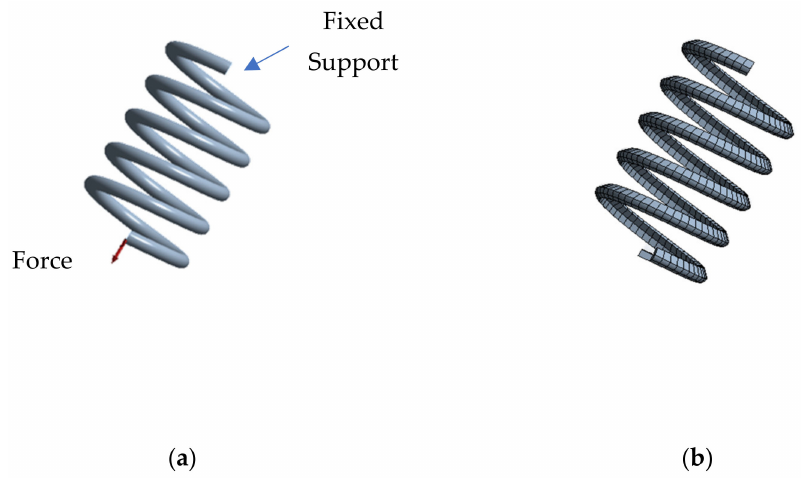
Figure 5. Model of the SMA spring ( a ) the geometrical model and boundary conditions, ( b ) finite element model (SOLID185 elements).